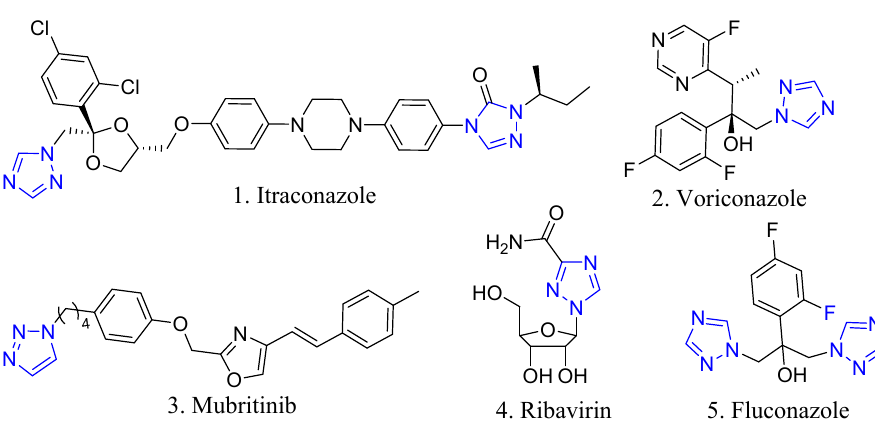
Figure 3. Some triazole-derived drugs.